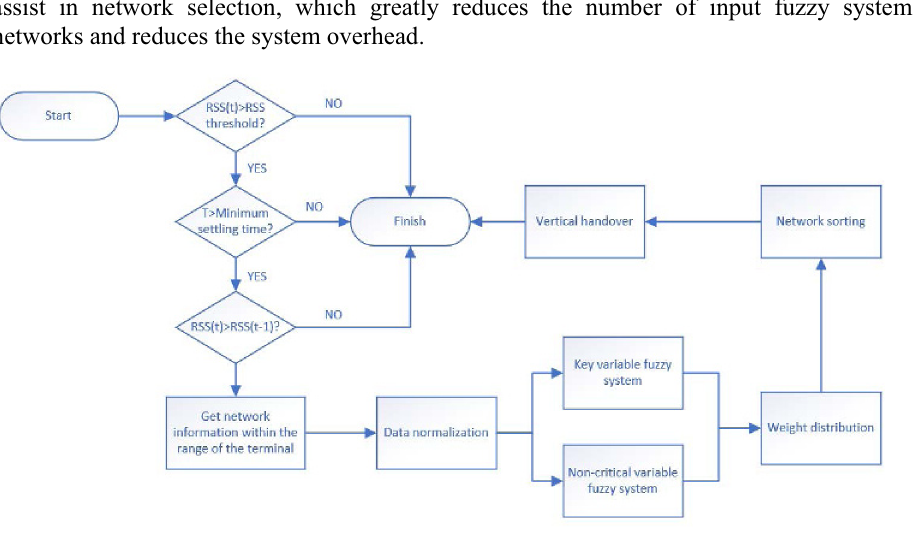
Fig. 1. Schematic diagram of decision